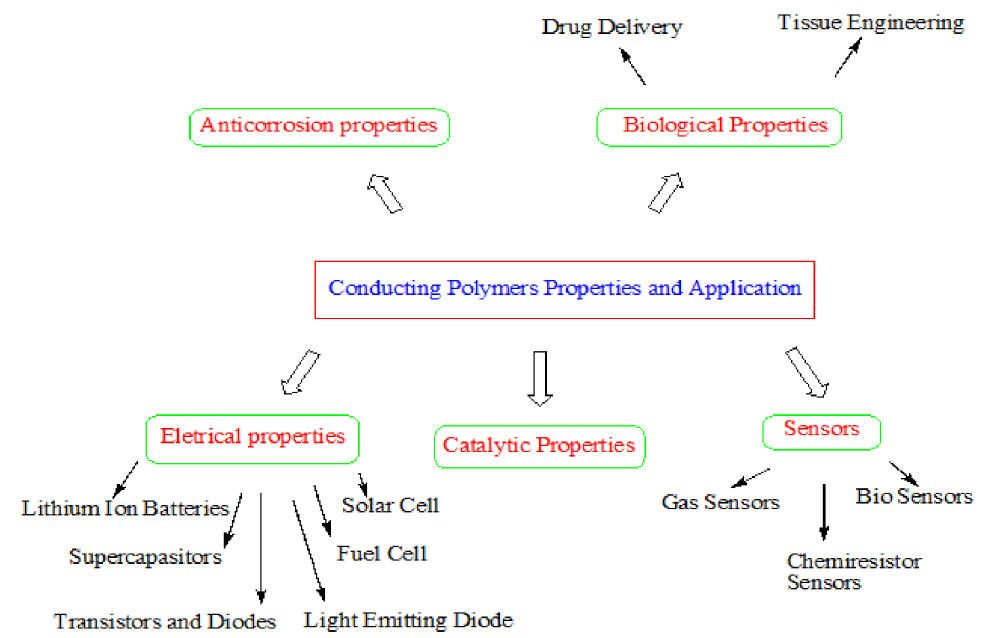
Figure 4. Reaction showing Chemical Polymerization of aniline. Reproduced with permission from